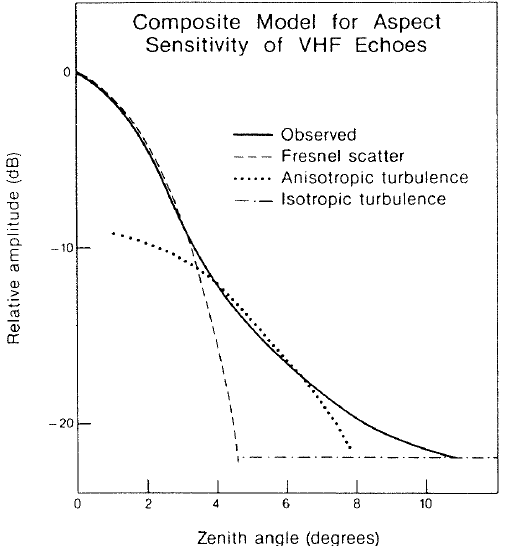
Fig. 9. Composite model for aspect sensitivity from Tsuda et al. (1986). Tsuda et al. (1997a) added the diffuse reflection on a rough surface that could replace the anisotropic turbulence in dot- ted lines.